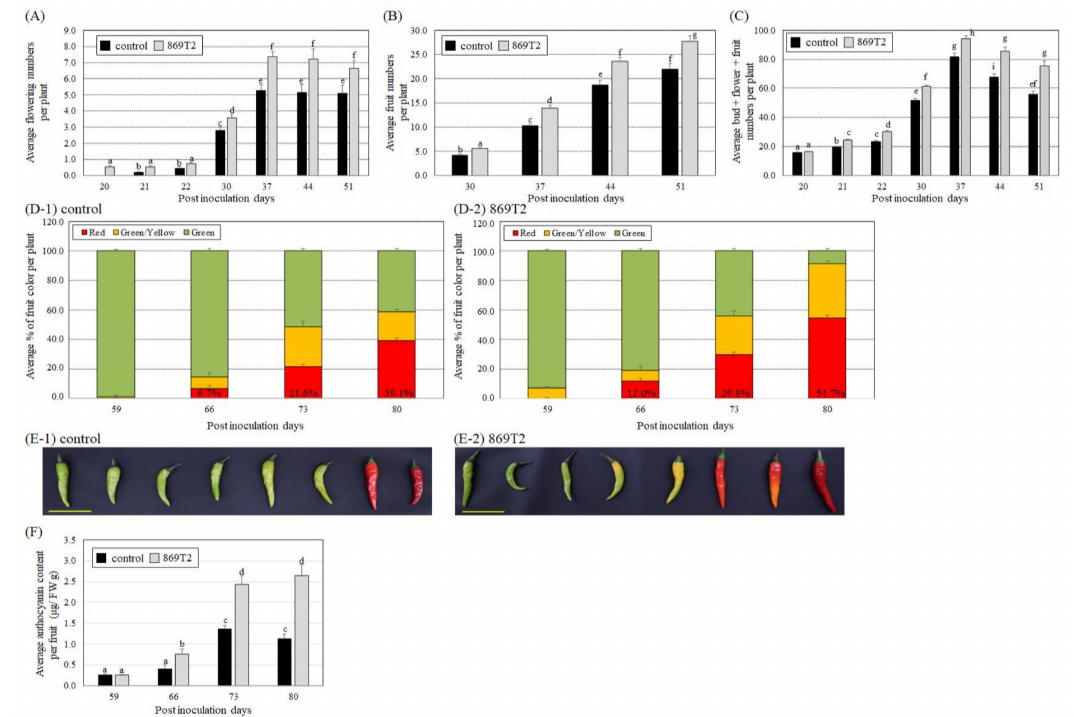
Figure 6. B. seminalis strain 869T2 inoculation caused hot pepper ( Capsicum annuum ) plants to have more flowers and fruits. The average values for the number of flowers ( A ), number of fruits ( B ), number of buds + flowers + fruits ( C ), and percentage of fruits of a given color ( D ) per plant were recorded for the control and inoculated plants after inoculation. Panel ( E ) shows photographs of fruits from the control ( E-1 ) and inoculated ( E-2 ) plants 73 days after inoculation. Yellow bar = 5 cm. After inoculation, the average anthocyanin content per fruit ( F ) was determined for the control and the 869T2-inoculated plants. Data are mean ± SE (standard error) from at least three independent bacteria inoculation experiments. More than 20 individual plants were examined for each bacteria inoculation assay. Duncan tests were used to analyze the data, and means with different letters were significantly different ( p <